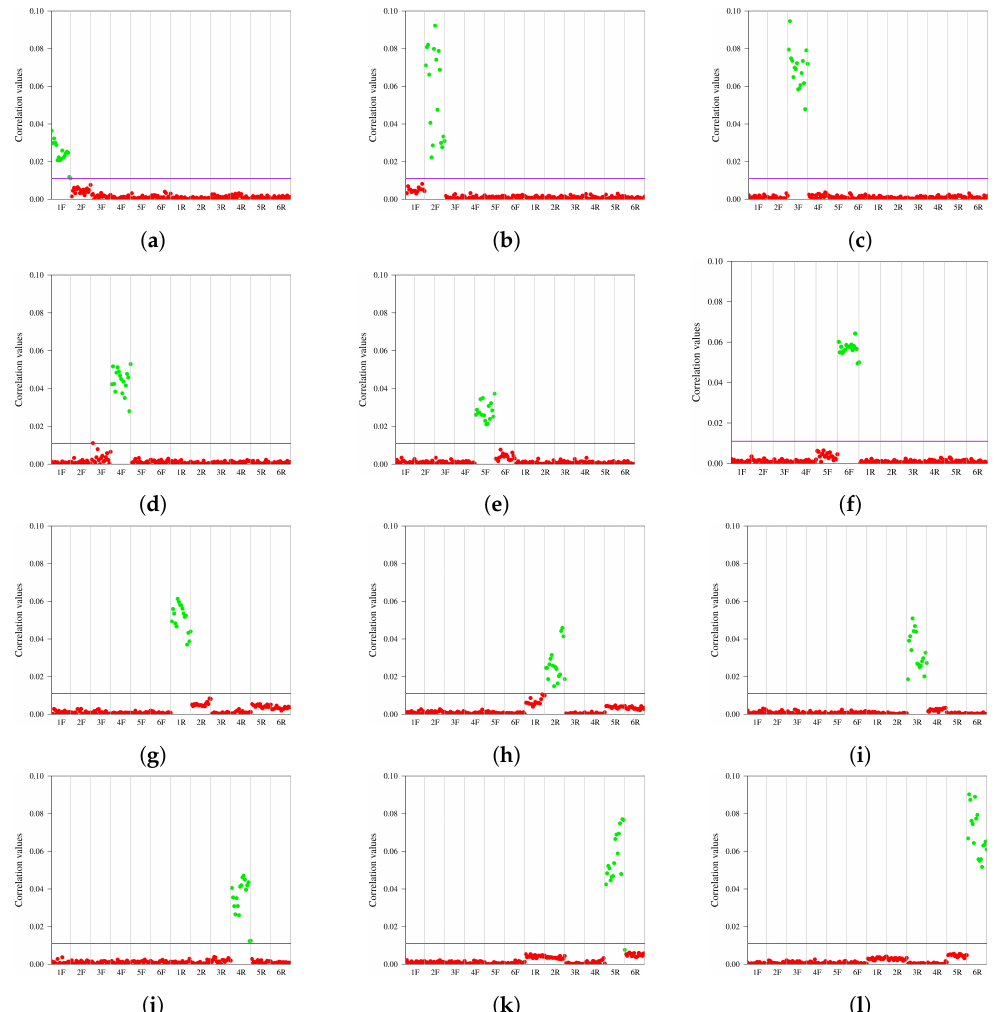
Figure 4. Correlation results for each of the twelve fingerprints: six for the front cameras ( a – f ) and six for the rear cameras ( g – l ); X F and X R identify the front and the rear camera, respectively, of a smartphone X